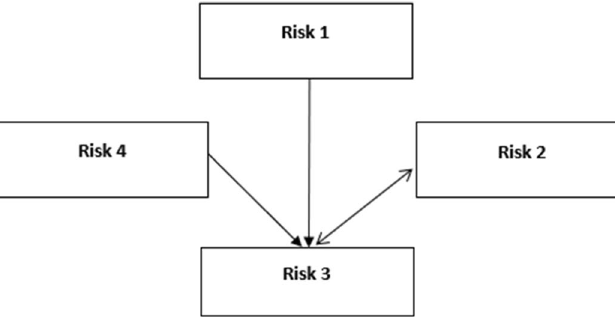
Fig. 3 Causal degrees for the risks